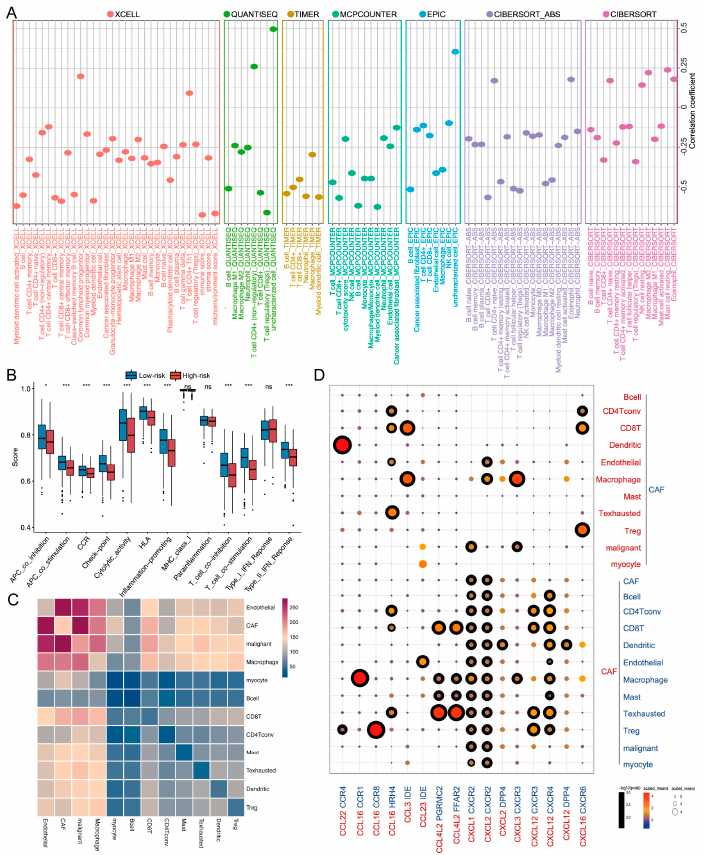
Figure 6. TME and single-cell landscape. ( A ) Correlation between risk score and immune cell infiltration via XCELL, QUANTISEQ, TIMER, MCPCOUNTER, EPIC, CIBERSORT_ABS, and CIBER- SORT. ( B ) Immune function analysis of the two risk groups by ssGSEA. ( C ) The number of potential ligand–receptor pairs between cell groups predicted by CellphoneDB. ( D ) Ligand–receptor pairs of chemokines and receptors between CAFs and other cell groups (solid sphere with black around it is defined as a statistical difference; solid sphere without black around it indicates no statistical dif- ference). ns, p > 0.05, * p < 0.05, ** p < 0.01, *** p < 0.001.